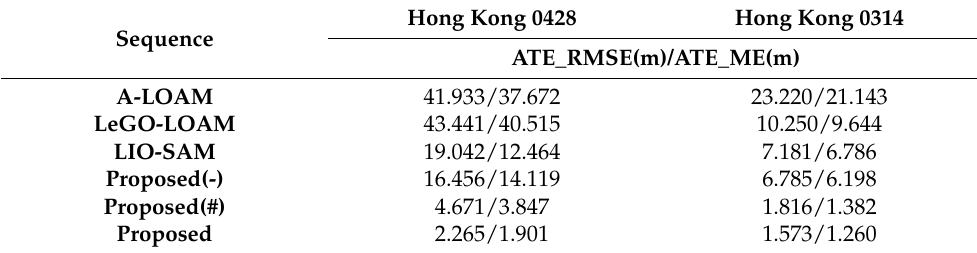
Figure 13. Comparison of the positioning error of each algorithm. ( a ) APE fitting curve. ( b ) The box diagram of APE.